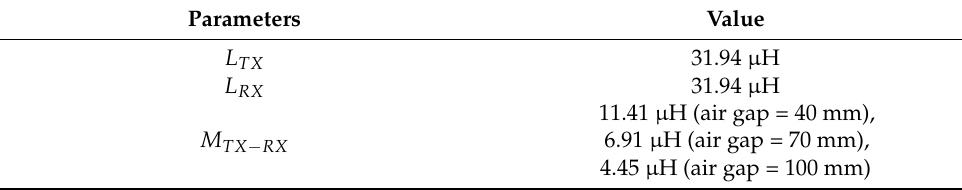
Table 3. Electrical parameters of TX and RX coils.